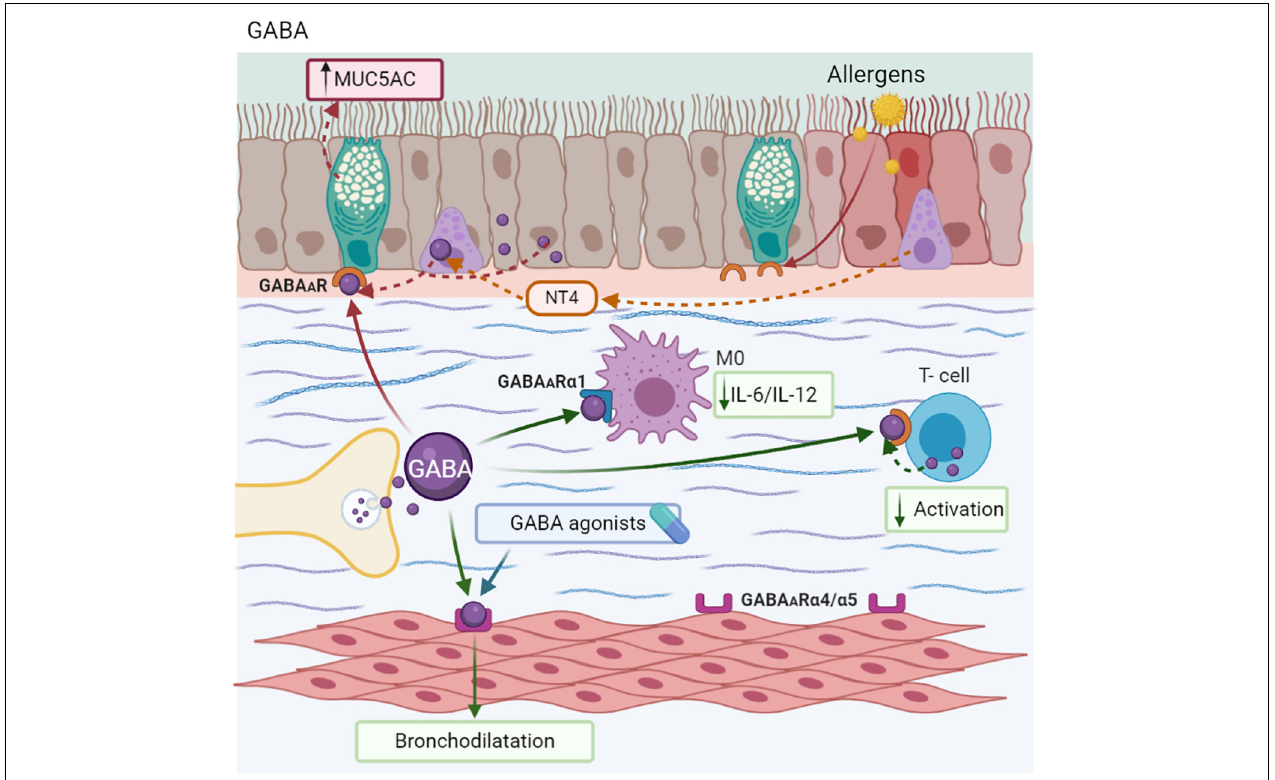
FIGURE 7 | Gamma-Aminobutyric acid-GABA. GABA is synthesized in nerve endings and also by PNEC, epithelium, and ASM. The aberrant production of GABA induced by Neurotrophin 4 (NT4) causes MUC5AC hypersecretion. However, GABA modulates T-cell activation and decreases the synthesis of IL-6 and IL-12